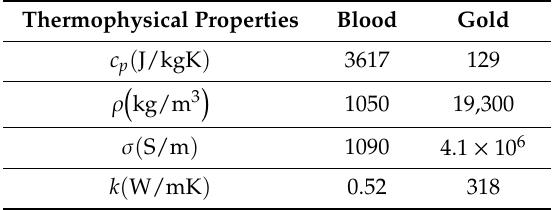
Table 1. Thermophysical properties of blood and gold nanoparticle [32].